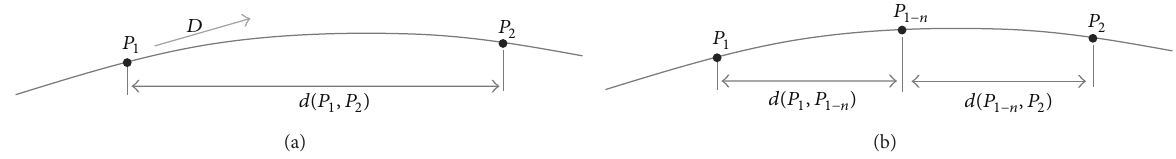
Figure 11: Remeshing algorithm. (a) 𝑃 1 and 𝑃 2 with distance 𝑑 on the intersection curve. (b) New generated point 𝑃 𝑛−1 between 𝑃 1 and 𝑃 2 .